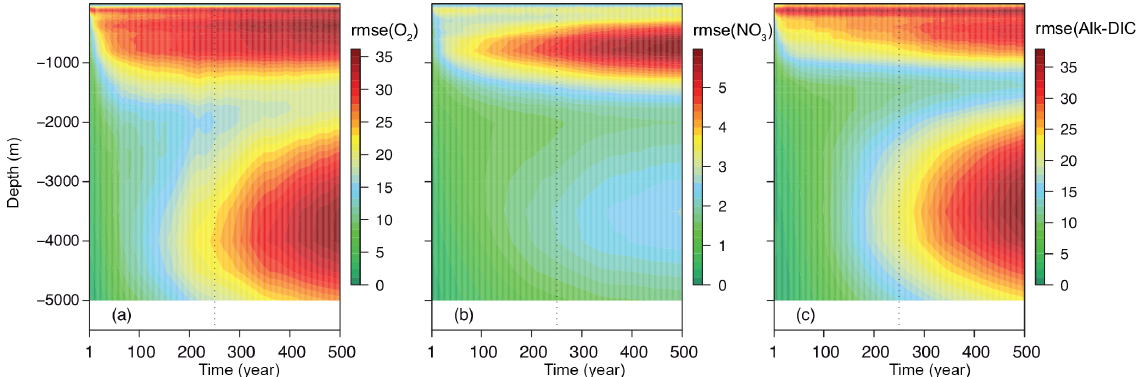
Figure 7. Temporal–vertical evolution in root-mean squared error (RMSE) for biogeochemical tracers during the 500-year long spin-up simulation of IPSL-CM5A-LR. The RMSE is given for (a) dissolved oxygen O 2 , (b) nitrate NO 3 and the (c) difference between alkalinity and dissolved inorganic carbon